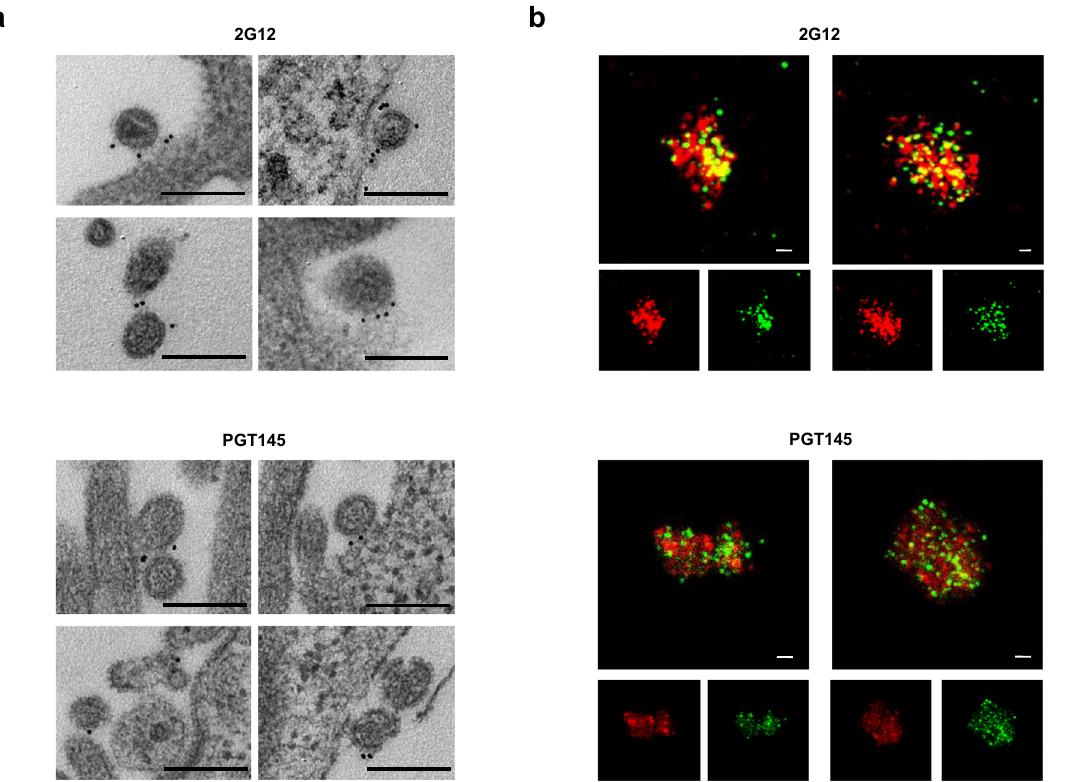
Fig. 4 IDLV-UFO.750 is pseudotyped with native-like trimeric envelope. a 293T Lenti-X cells producing IDLV-UFO.750 were probed with 2G12 (top panel) or PGT145 (bottom panel) bNAbs and observed by TEM. Four representative images are shown for each bNAb staining. Bars, 0.2 μ m. b CLSM observation of GFP-labeled IDLV-UFO.750 obtained by adding a plasmid expressing SIVGag protein fused to GFP during production. Puri fi ed particles were immuno-stained with anti-Env 2G12 bNAb (top panel) or trimer-speci fi c PGT145 bNAb (bottom panel) and anti-human IgG Alexa Fluor 647 secondary Ab (red). Top panels show the merged images in which the yellow dots represent the overlapping green (SIVGag-GFP) and red (UFO.750) signals. Bottom panels represent the individual fl uorescent images. Two representative images for each Ab staining are shown. Bars, 5 μ m. Shown are results from one representative of n = 2